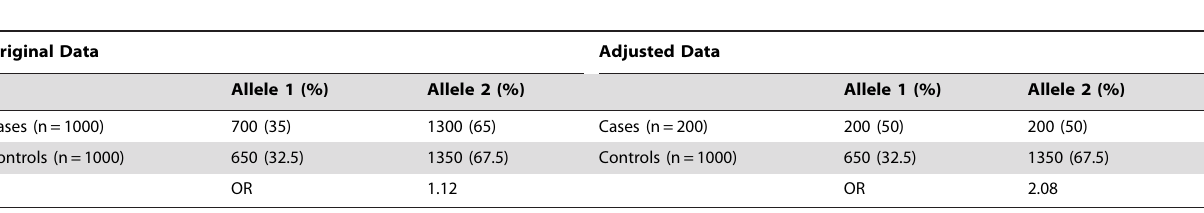
Table 7. A hypothetical example illustrating that in data with 1000 cases and 1000 controls, if a SNP had altered frequency only in a subgroup of 200 cases, the OR would be